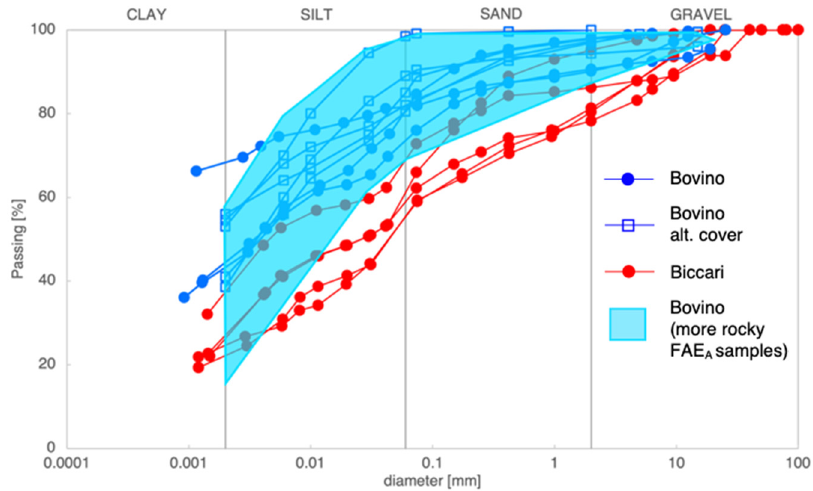
Figure 12. GSD curves for Faeto Flysch at Bovino and Biccari.